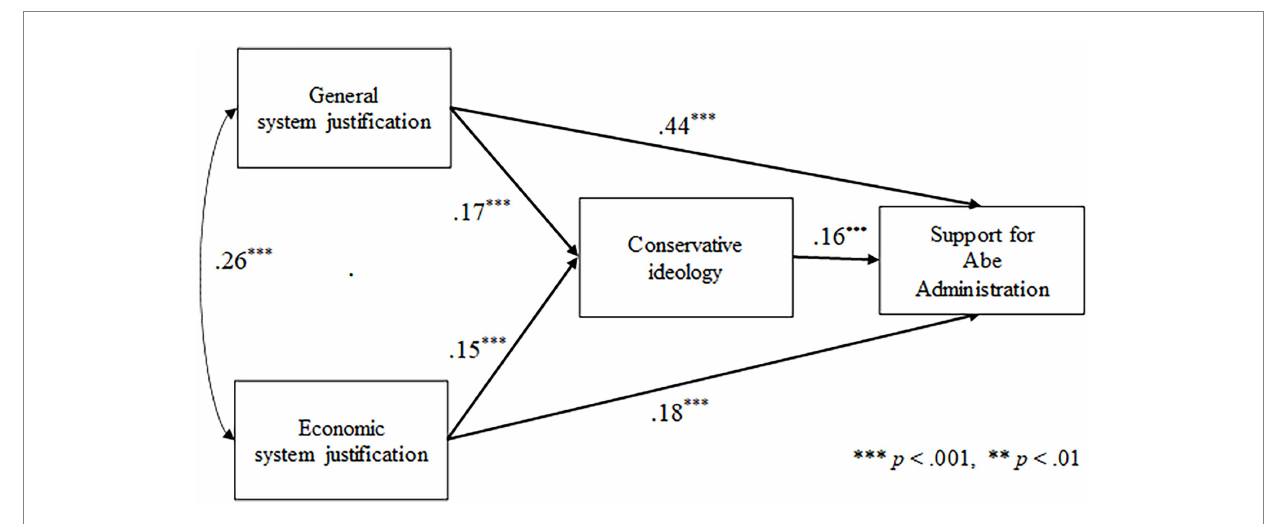
FIGURE 1 Results of the mediation analysis using standardized regression